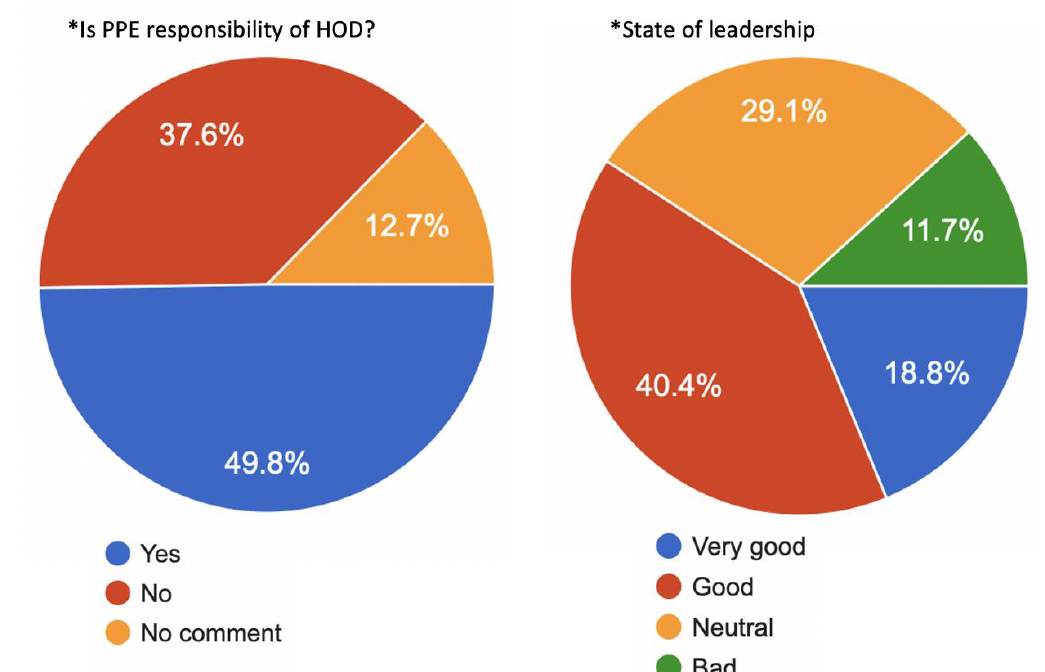
Figure 1. Perception of departmental leadership (n= 213; PPE = Personal Protective Equipment; HOD = Head of